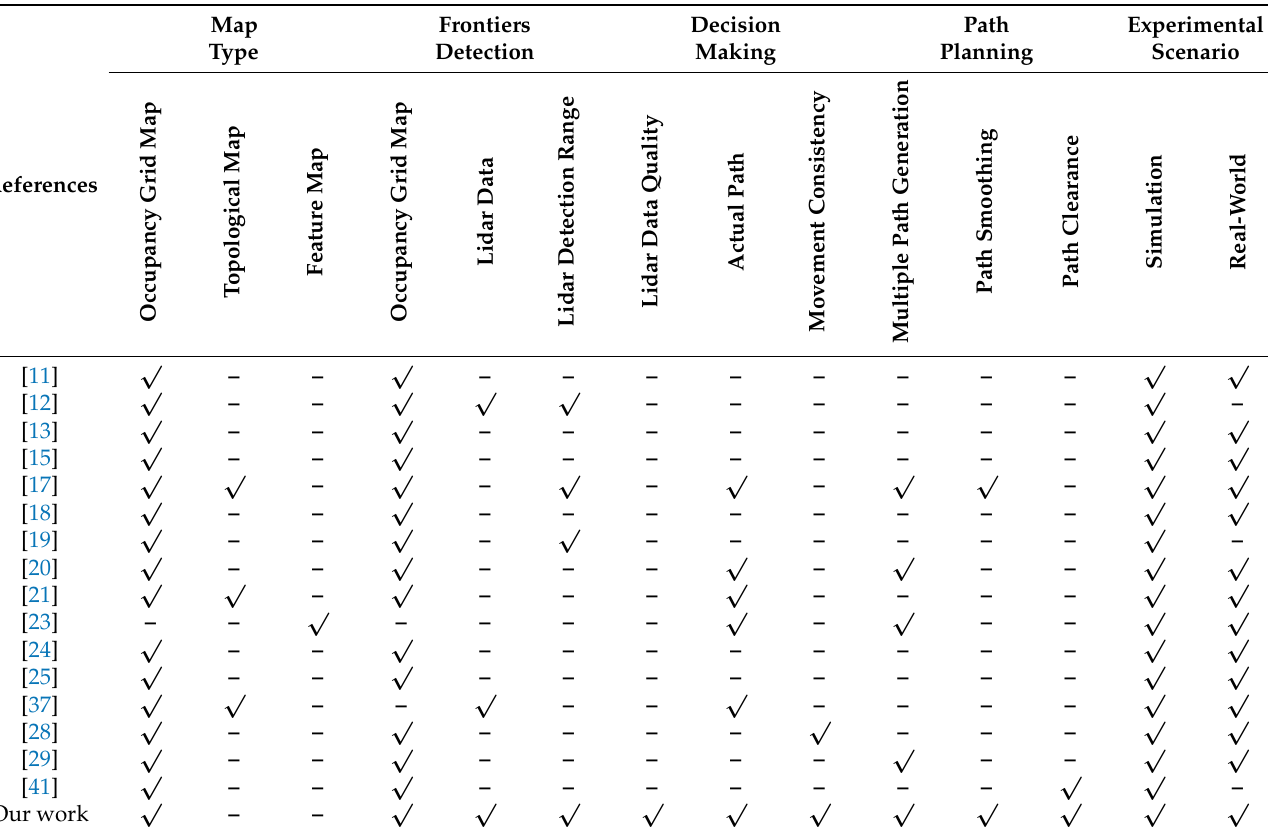
Table 1. Comparison of our proposed work with related works.